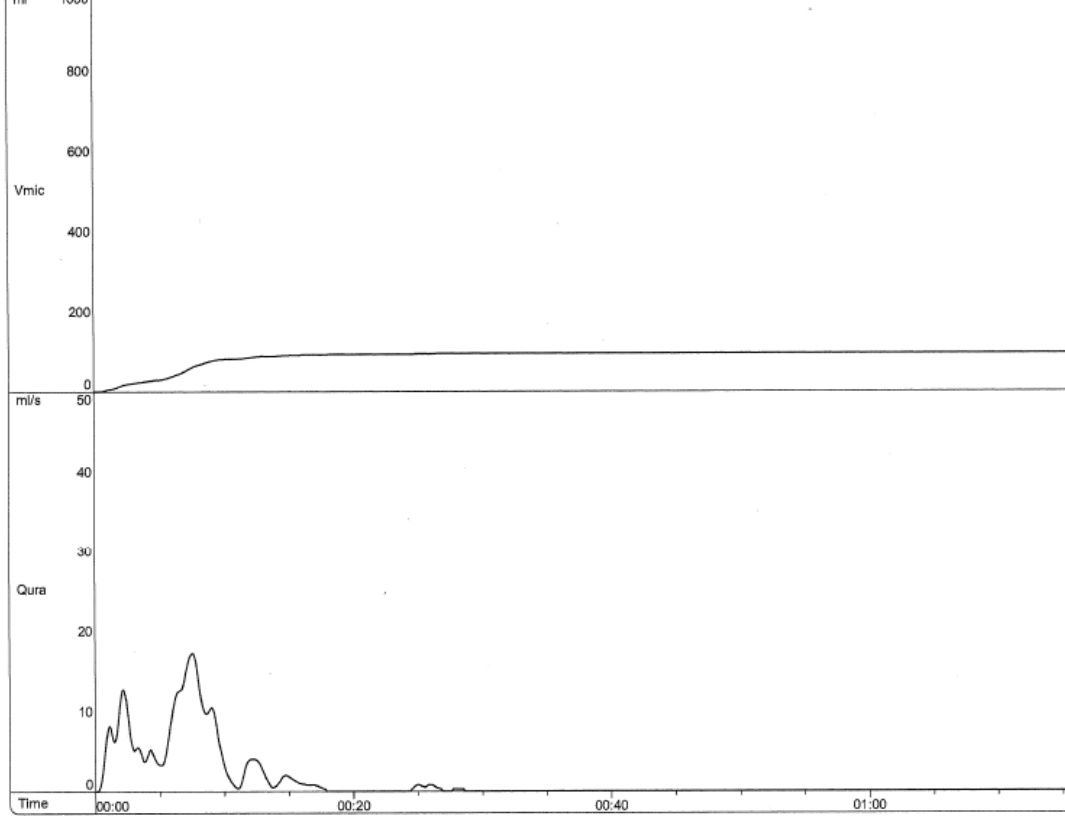
Figure 1. Uroflow (2015) Initial visit to clinic (Staccato and prolonged).